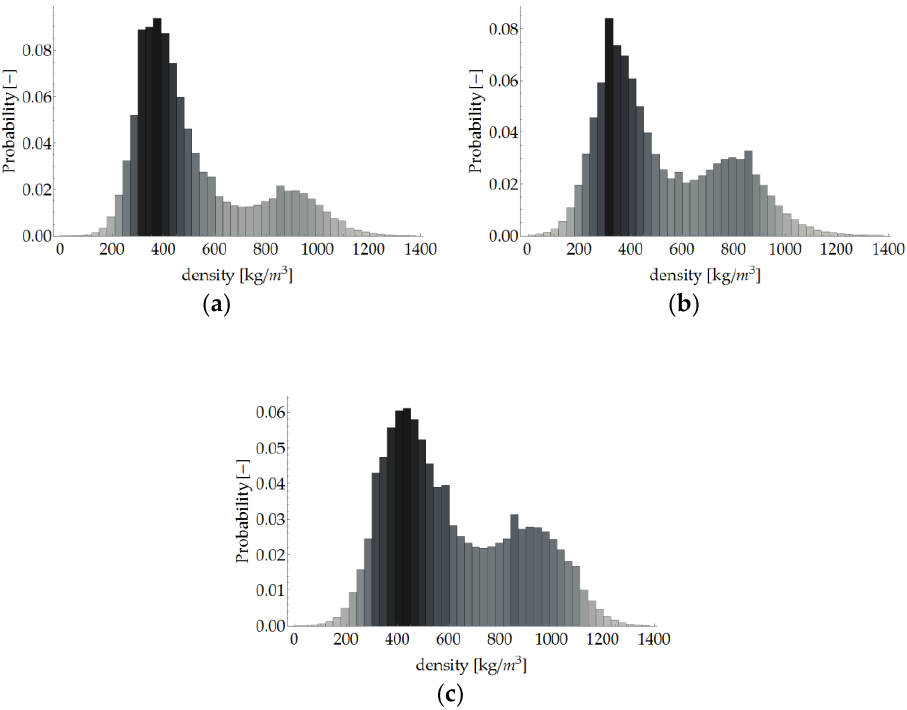
Figure 17. Spatial distribution of density: ( a ) “1” ; ( b ) “2” and ( c ) “3”.